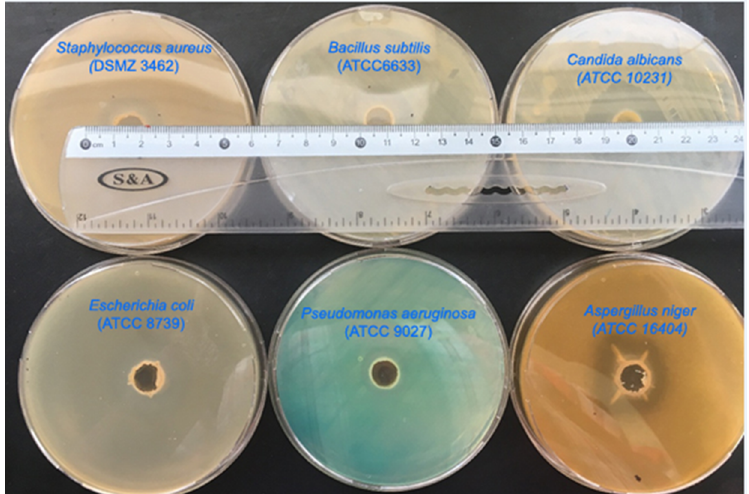
Figure 1. The antimicrobial activity of the SCGS using a modified agar well diffusion method against (a) strains Staphylococcus aureus (DSMZ 3463), Bacillus subtilis (ATCC 6633), Escherichia coli (ATCC 8739), Pseudomonas aeruginosa (ATCC 9027), Candida albicans (ATCC 10231), and Aspergillus niger (ATCC 16404).